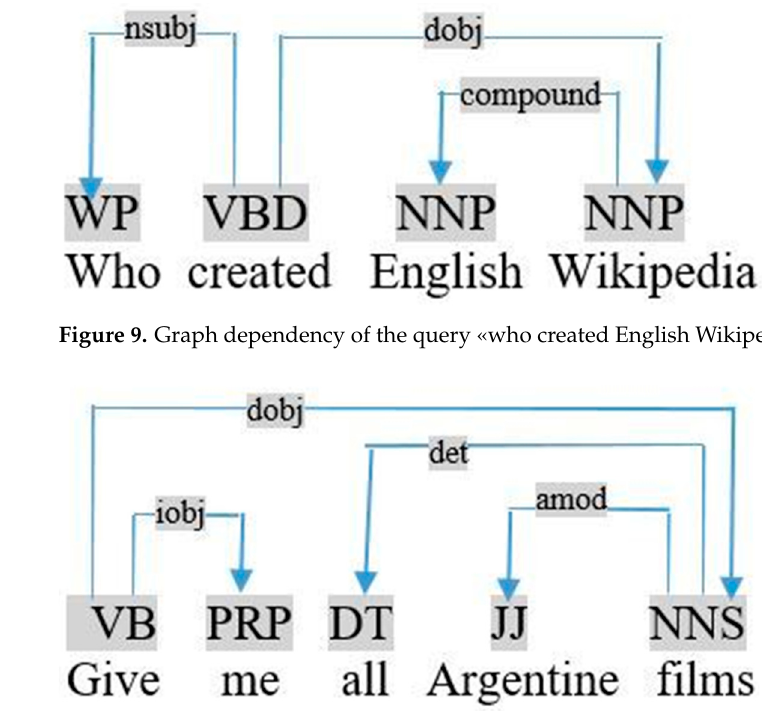
Figure 10. Graph dependency of the query «give me all Argentine films».